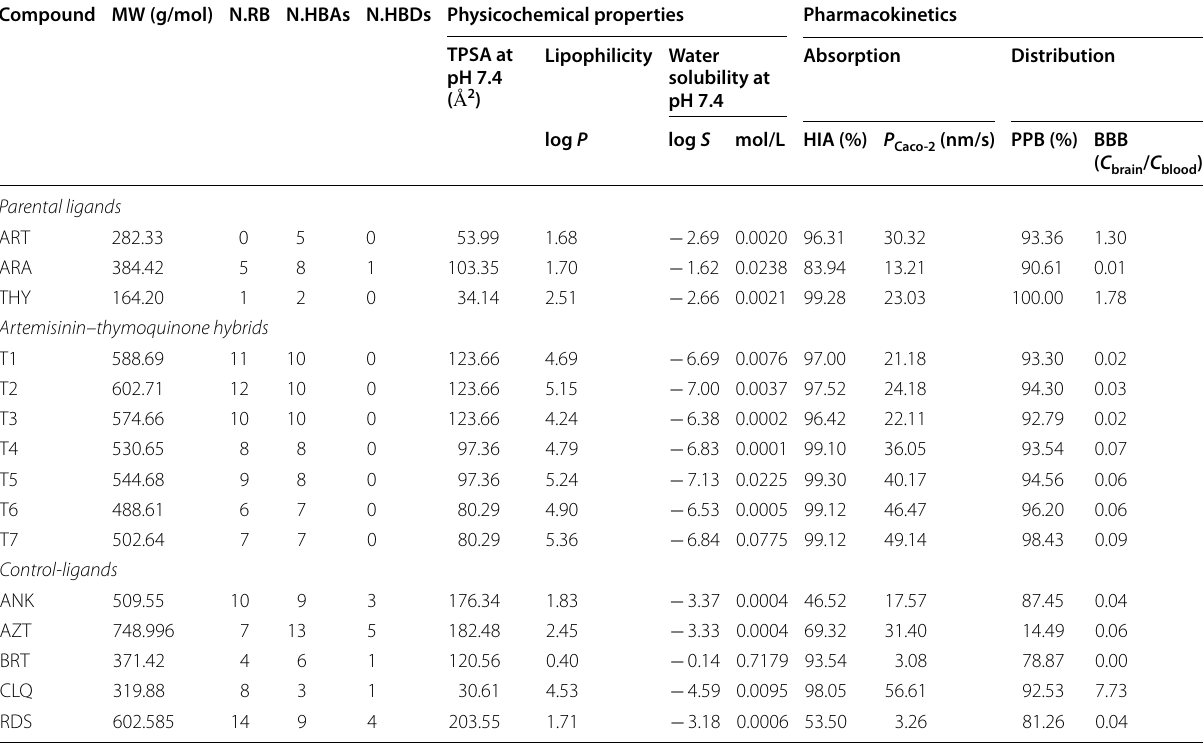
AZT azithromycin, BRT baricitinib, RDS remdesivir, ANK anakinra, CLQ chloroquine, ART artemisin, ARA artemisin acid, THY thymoquinone